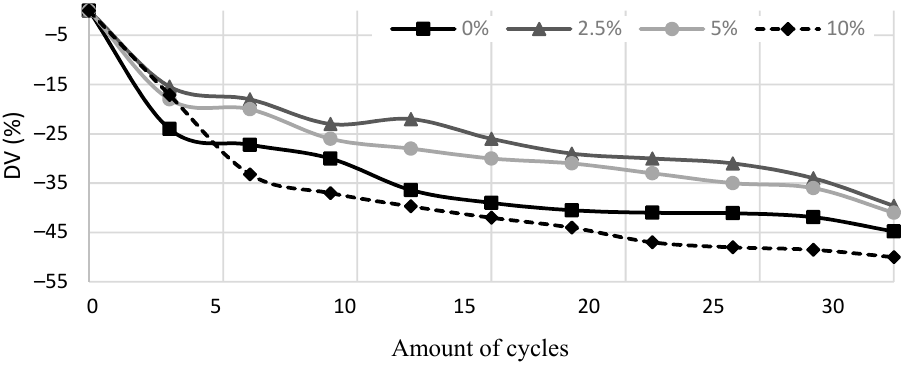
Figure 5. Variation of ultrasonic pulse velocity (DV) during thermal cycling of specimens with different HCM content.